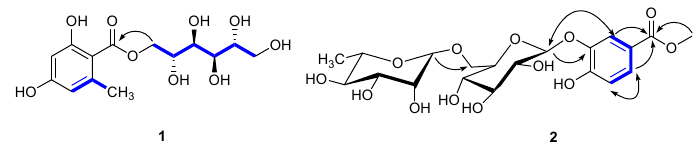
Figure 2. Key HMBC (H ⟶ C), 1 H- 1 H COSY ( − ), and NOESY ( ⟷ ) of new compounds 1 , 2 isolated from X. sorbifolia husks.